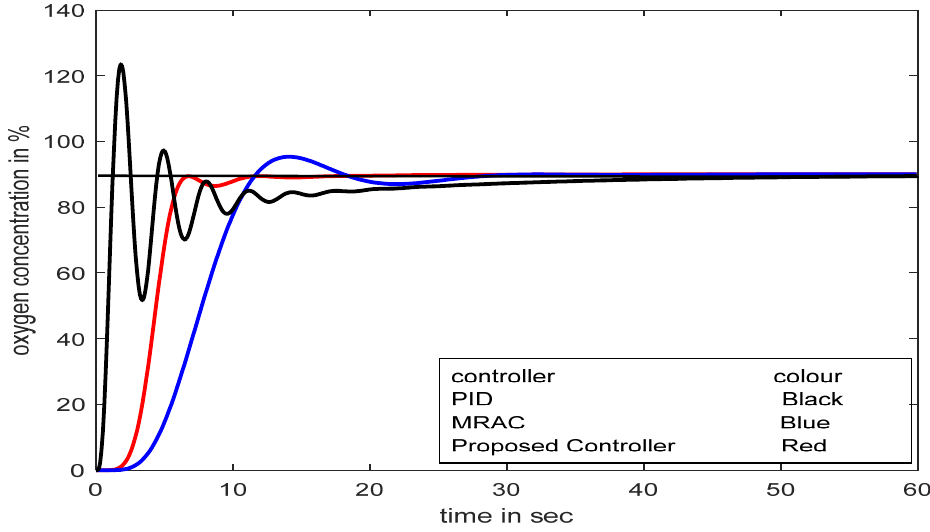
Figure 17. Comparative studies between PID, MRAC, and SFPIMRAC with set ‐ point at 90% SpO 2 .